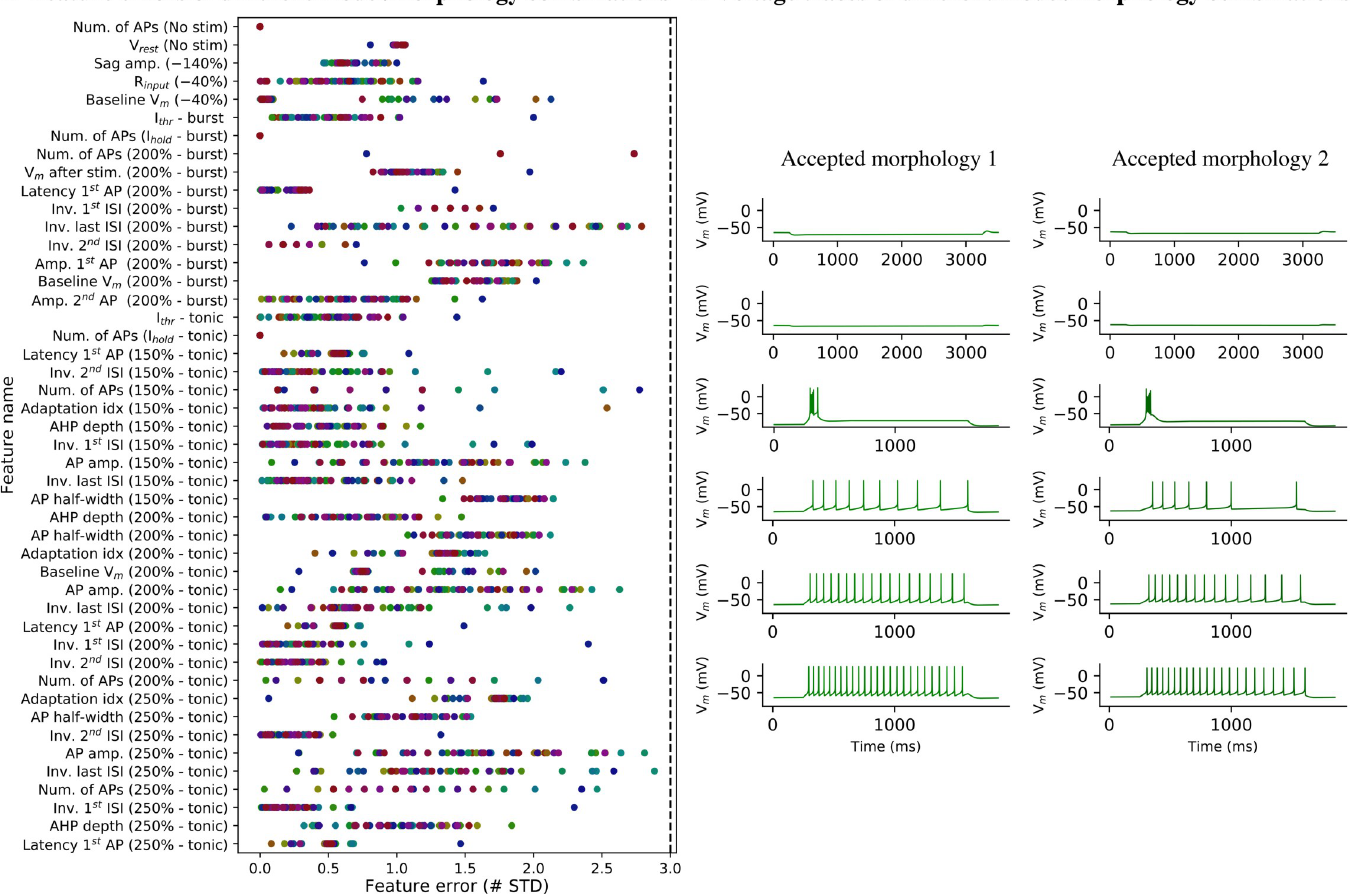
Fig 8. Model generalization to different experimental morphologies. (A) Feature errors from the best electrical models (e-models) showed in Fig 4 applied to 50 different TC cell morphologies. Each morphology is represented with a different color. None of the e-models/morphology combinations were rejected, because all the feature errors were < 3 STD (dashed line). (B) Example of voltage responses from two accepted e-model/morphology